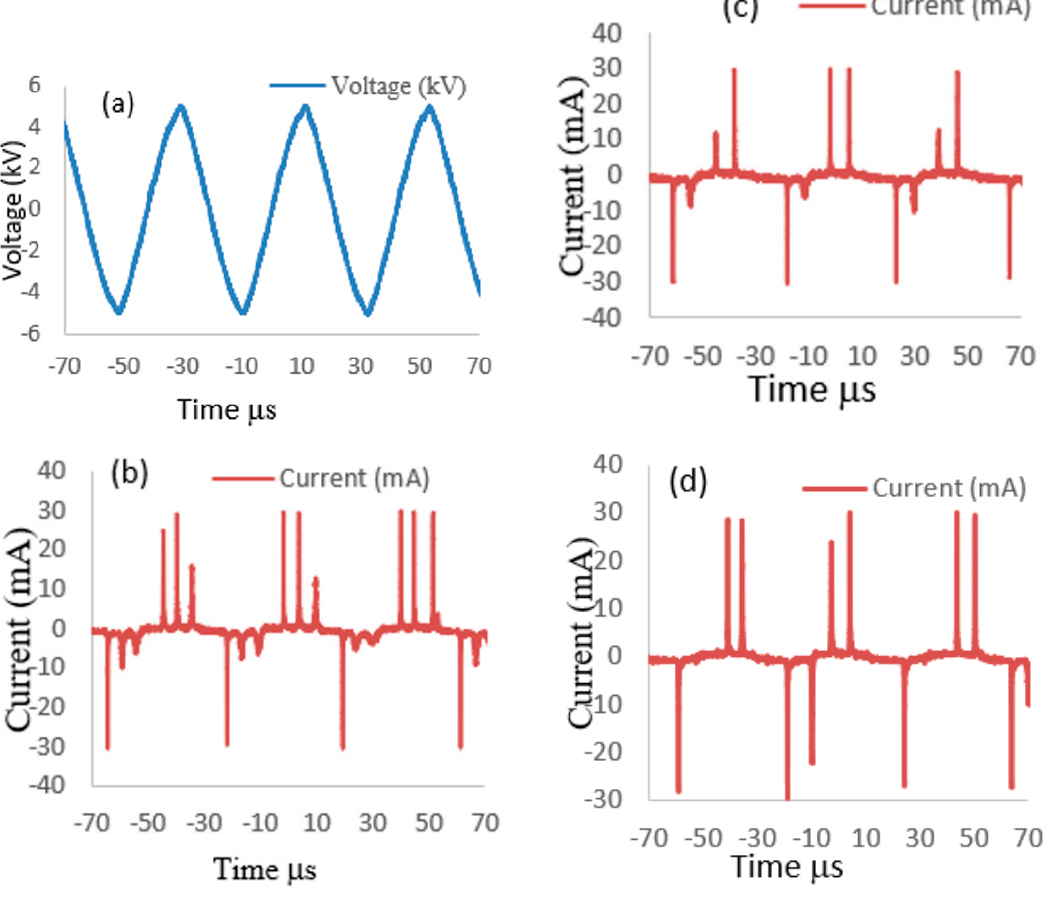
Figure 2. ( a ) Voltage waveform and current waveforms for ( b ) 1 slm argon gas, ( c ) admixture of argon 1 slm / 0.25% oxygen, and ( d ) admixture of argon 1 slm / 1.5% oxygen.